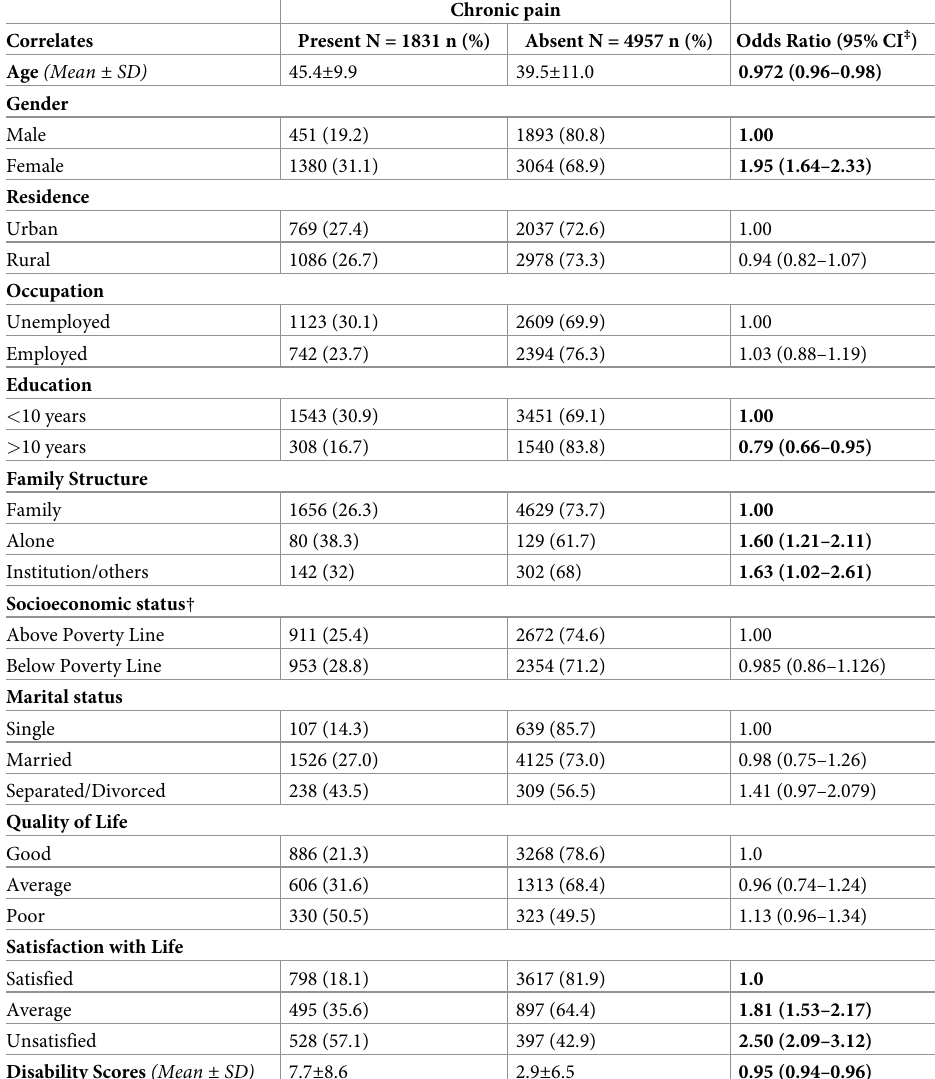
Table 2. Socio-demographic & clinical correlates of subjects with chronic pain �